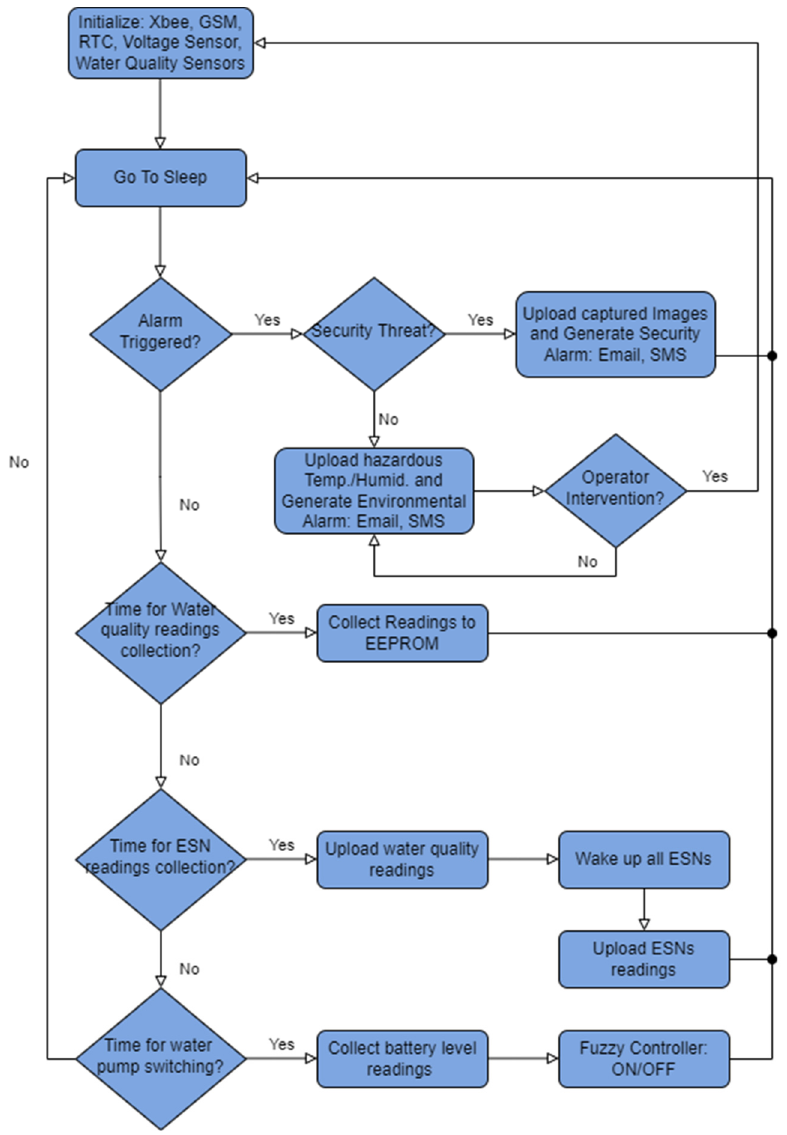
Figure 4. SCU flowchart.